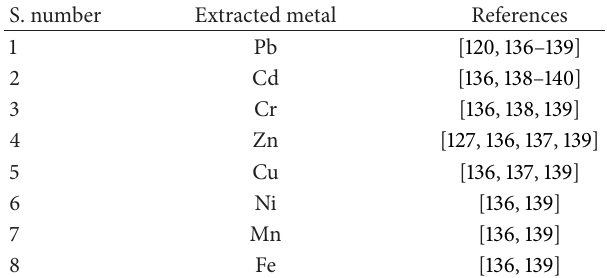
Table 4: Useful biological activities, effects, and some uses of Parthenium hysterophorus weed